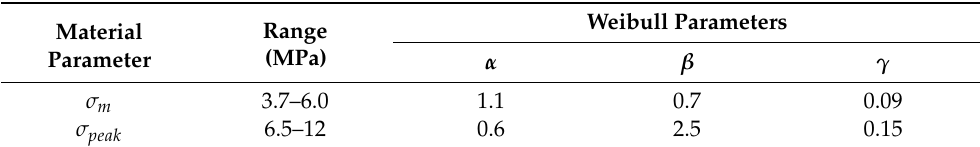
Table 7. Strength and Weibull parameters of the reference, plain SHCC model as presented in Figure 12.